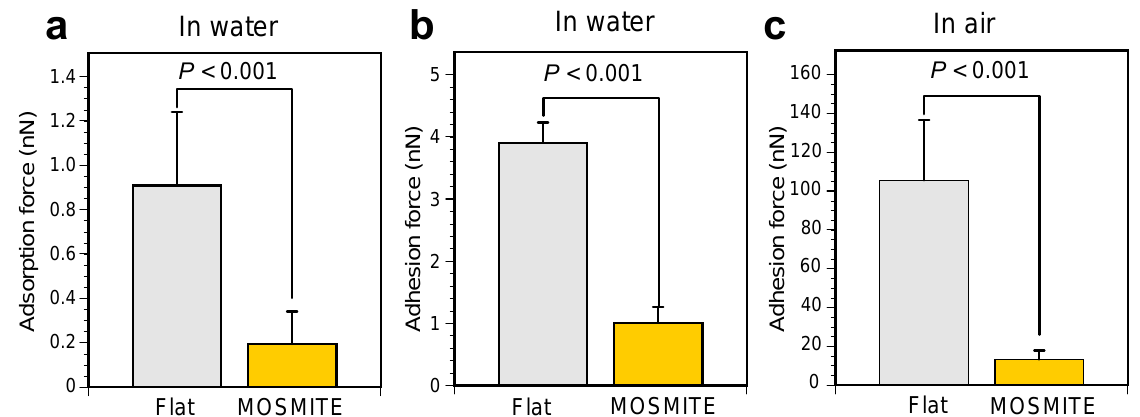
Figure 4. Comparison of the adsorption force and adhesion force on the flat surface and the MOSMITE™ surface. ( a ), Adsorption force under water. ( b ), Adhesion force under water. ( c ), Adhesion force in the air. Significant differences were tested using the Mann – Whitney U -test.